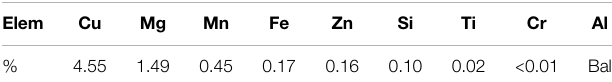
TABLE 3 | Nominal chemical composition of AA2024-T3 (wt%).